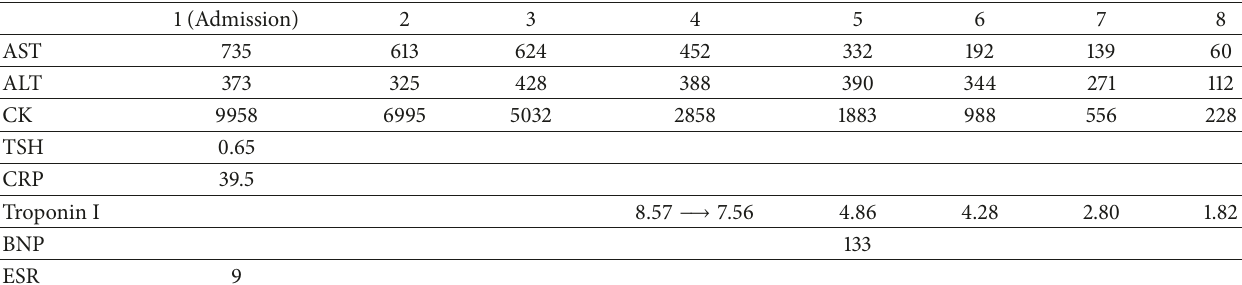
Table 2: Selecting laboratory values during hospital stay by